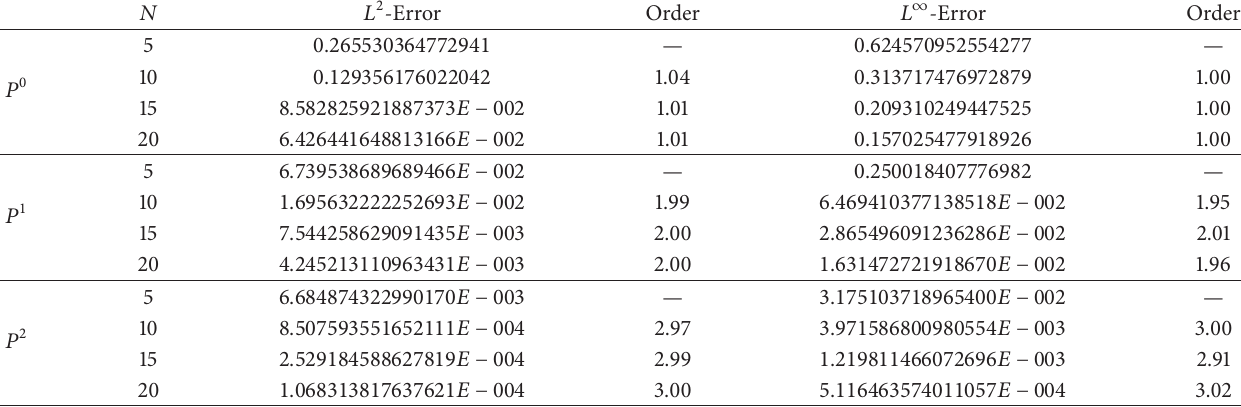
Table 7: Spatial accuracy test for the fractional order equation with the forcing term (42). 𝛼 = 0.7 , 𝑀 = 10 4 , 𝑇 = 1 . 𝑁 𝐿 2 -Error Order 𝐿 ∞ -Error Order 𝑃 0